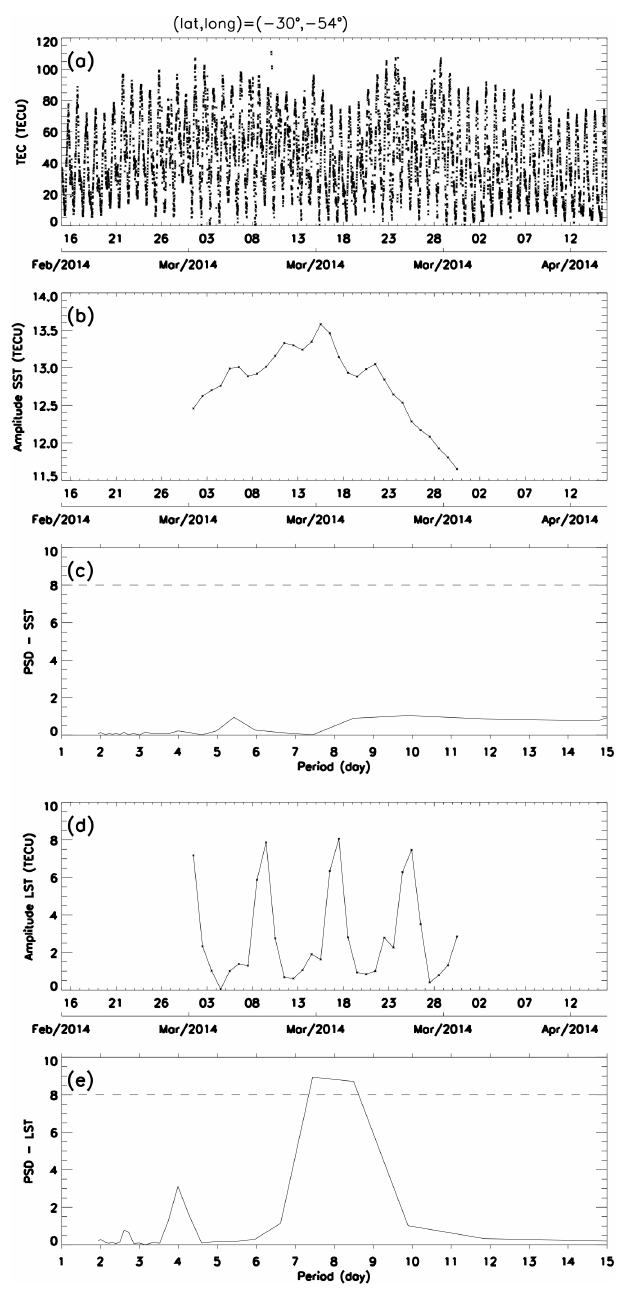
Figure 2. (a) TEC collected at 30 ◦ S and 54 ◦ W from February to April 2014. (b) Amplitudes of the semidiurnal solar tide calculated from (a) . (c) Periodogram for the amplitudes of the semidiurnal solar tide. (d) Amplitudes of the semidiurnal lunar tide calculated from (a) . (e) Periodogram for the amplitudes of the semidiurnal lu- nar tide. The horizontal dashed line represents the confidence level of 99%.